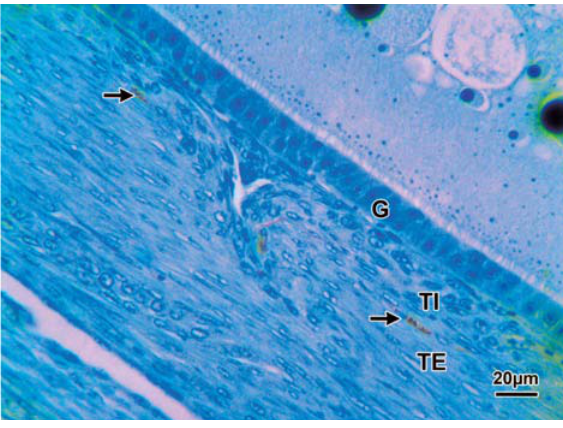
A network of NSE immunoreactive nerve fibres (ar- rows) is present at the interface between intramural veins (M) and interstitial gland cells (IG) in an atretic vitellogenic